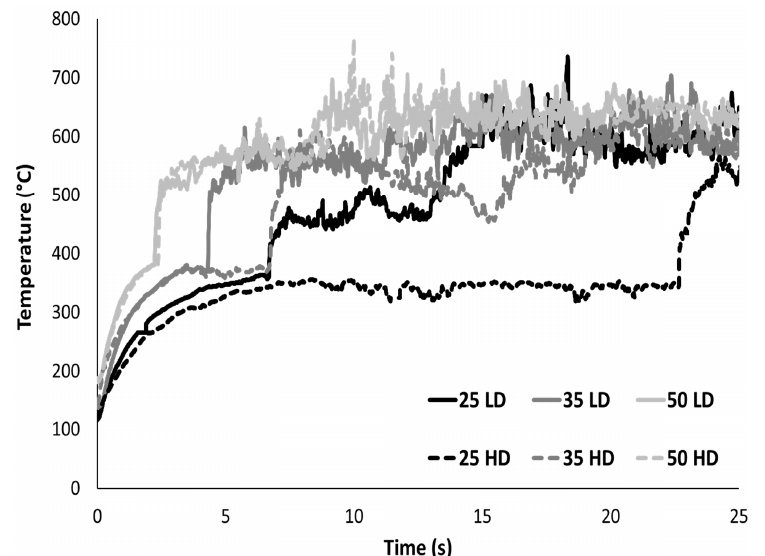
Figure 5. Temperature of the upper surface for both foams at different heat fluxes in cone calorimeter tests (sample thickness 2 cm). Cone calorimeter tests were also performed on 10 cm-thick foams to study the foam collapse during burning. In order to easily study the collapse, the external heat flux was fixed at 10, 25 and 35